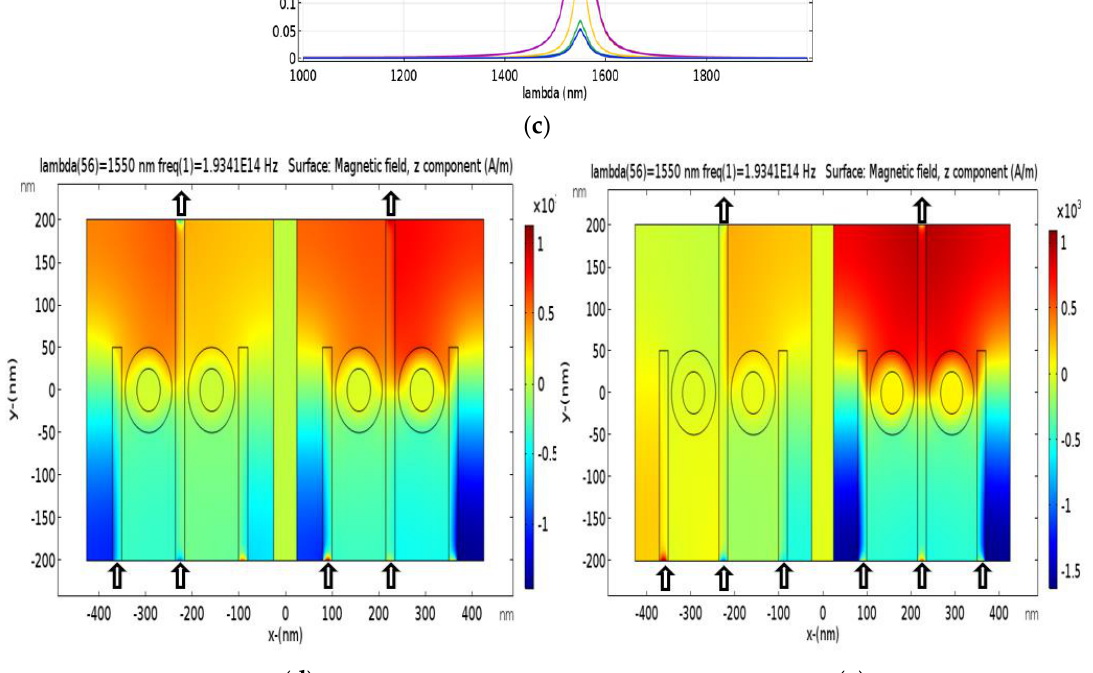
Figure 3. ( a ) and ( b ) the conventional half-subtractor logic diagram and its truth table, respectively. ( c ) The transmission spectrum of the proposed plasmonic half-subtractor for different states, according to its truth table. ( d ) and ( e ) the magnetic field distribution of Logic 10 and Logic 11 inputs, respectively.